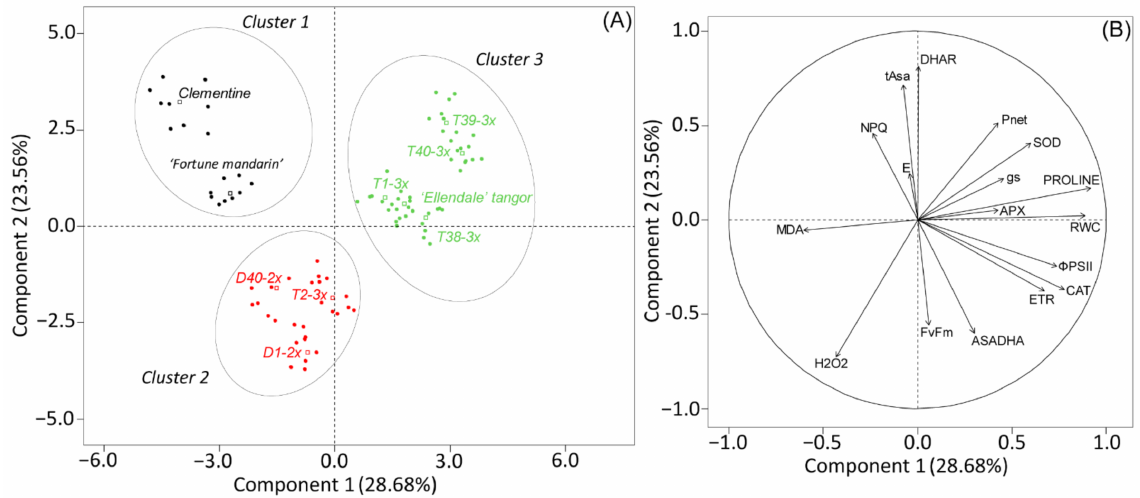
Figure 5. Principal component analysis (PCA) performed on leaves of 2x and 3x genotypes subjected to water deficit. ( A ) Clustering of genotypes on the two first components and ( B ) contribution of each physiological and biochemical parameter to the two first components of